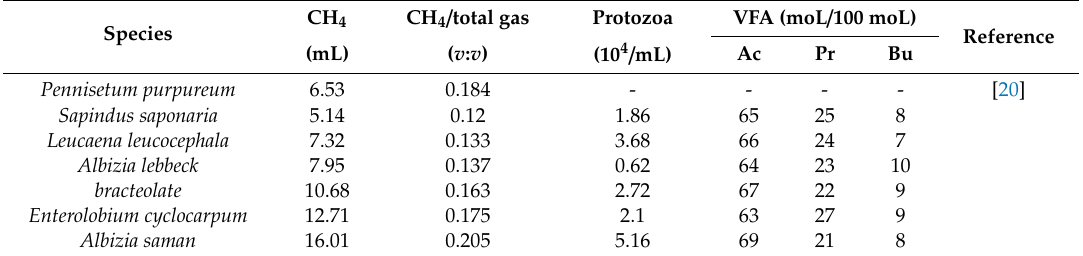
Table 4. Potential of foliage and seeds of tropical trees for methane (CH 4 ) mitigation, rumen defaunation, and changes in the molar proportions of volatile fatty acids in